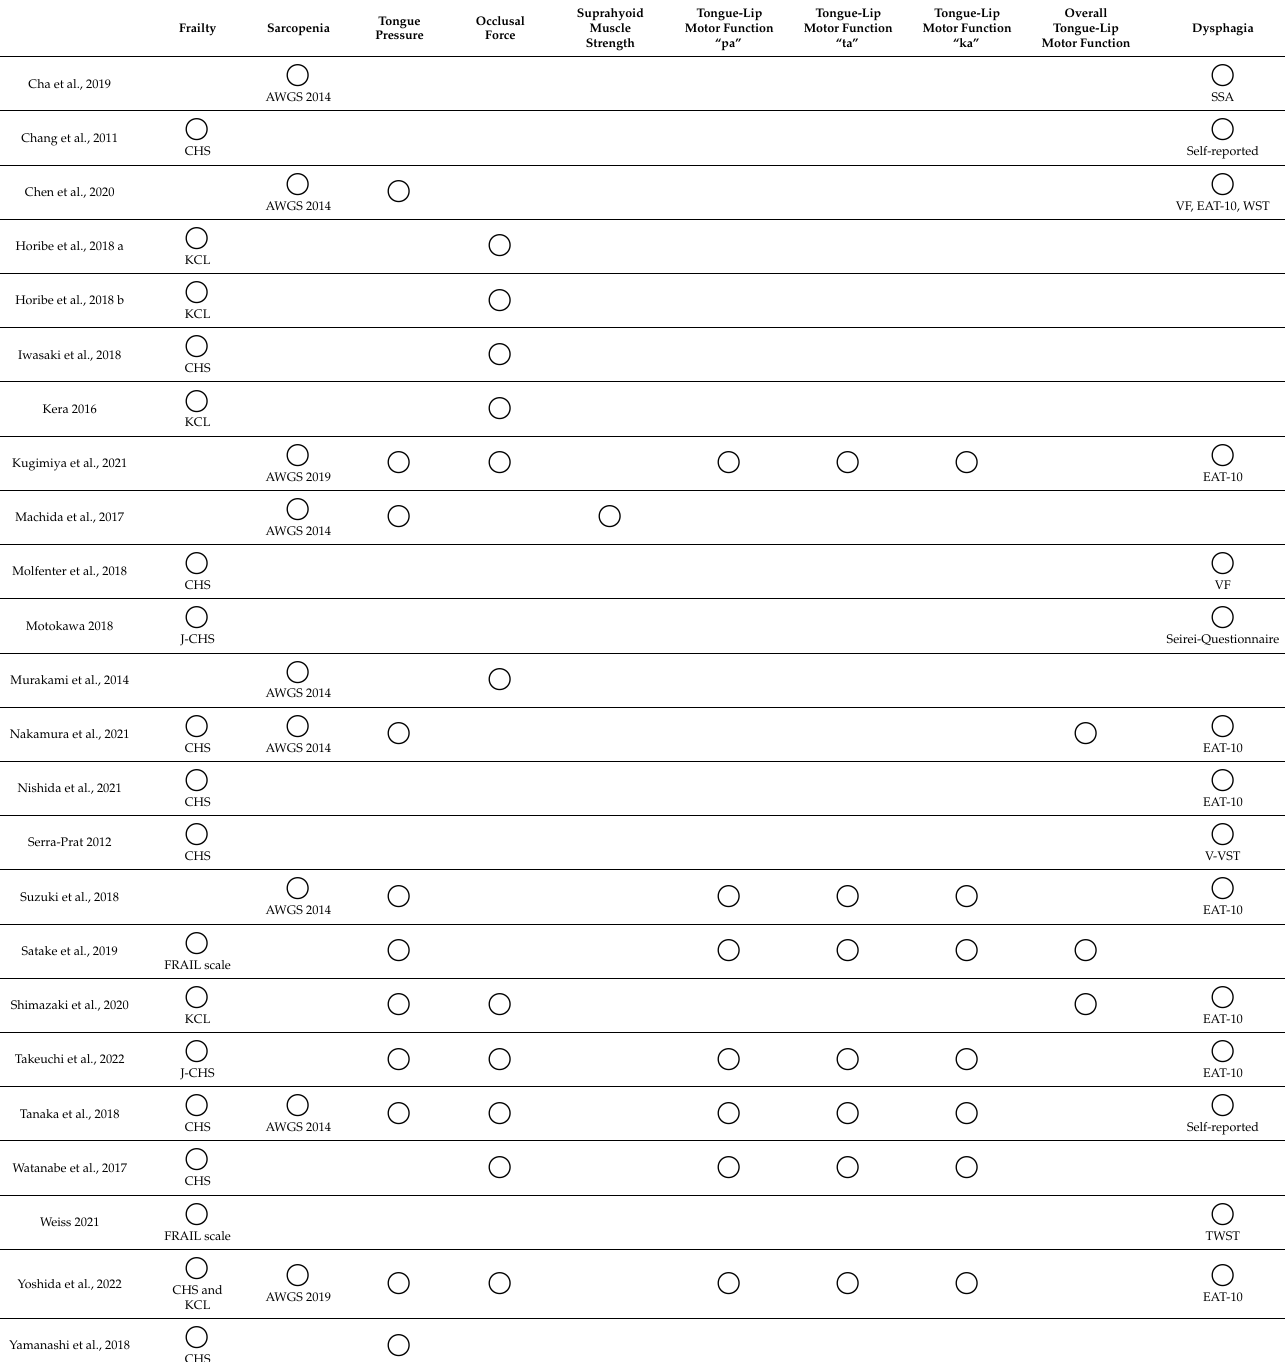
Table 2. Items assessed and tools used in studies.